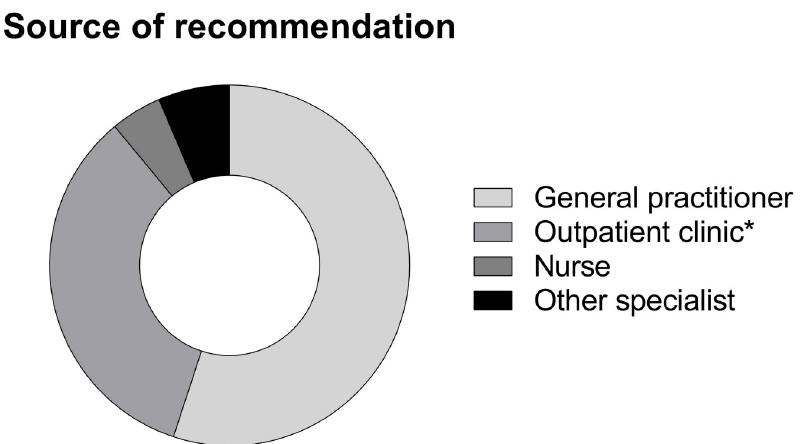
Fig 2. Source of recommendation in patients undergoing vaccination. Fig 2 illustrates relative frequencies of reported sources of recommendations for influenza vaccination in patients who underwent vaccination in the last season. Relative frequencies: general practitioner N = 60/58.8%, outpatient clinic ( � including dialysis unit) N = 37/ 36.3%, nurses N = 5/4.9%, external specialist N =